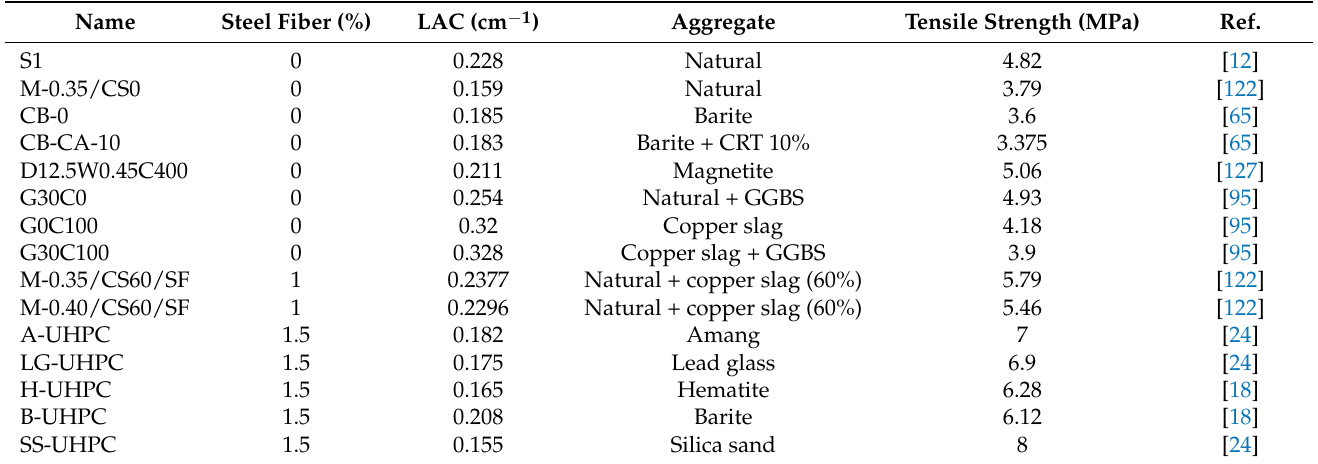
Table 6. List of RSC with tensile strength value.